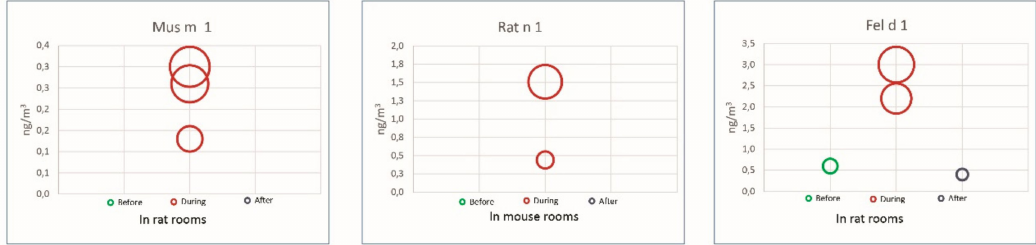
Figure 1. Aeroallergen levels over three consecutive days in mouse and rat rooms: before, during and after changing cages (Each circle represents the observed value and dimension / diameter indicates the